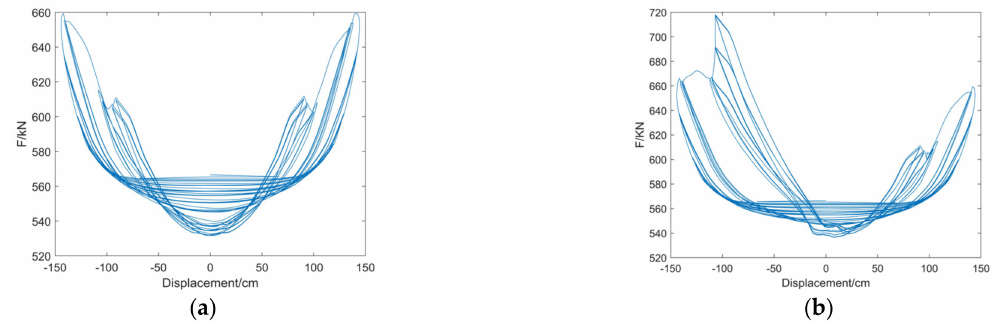
Figure 9. Force-displacement diagrams of tendons: ( a ) A2 specimen; ( b ) B2